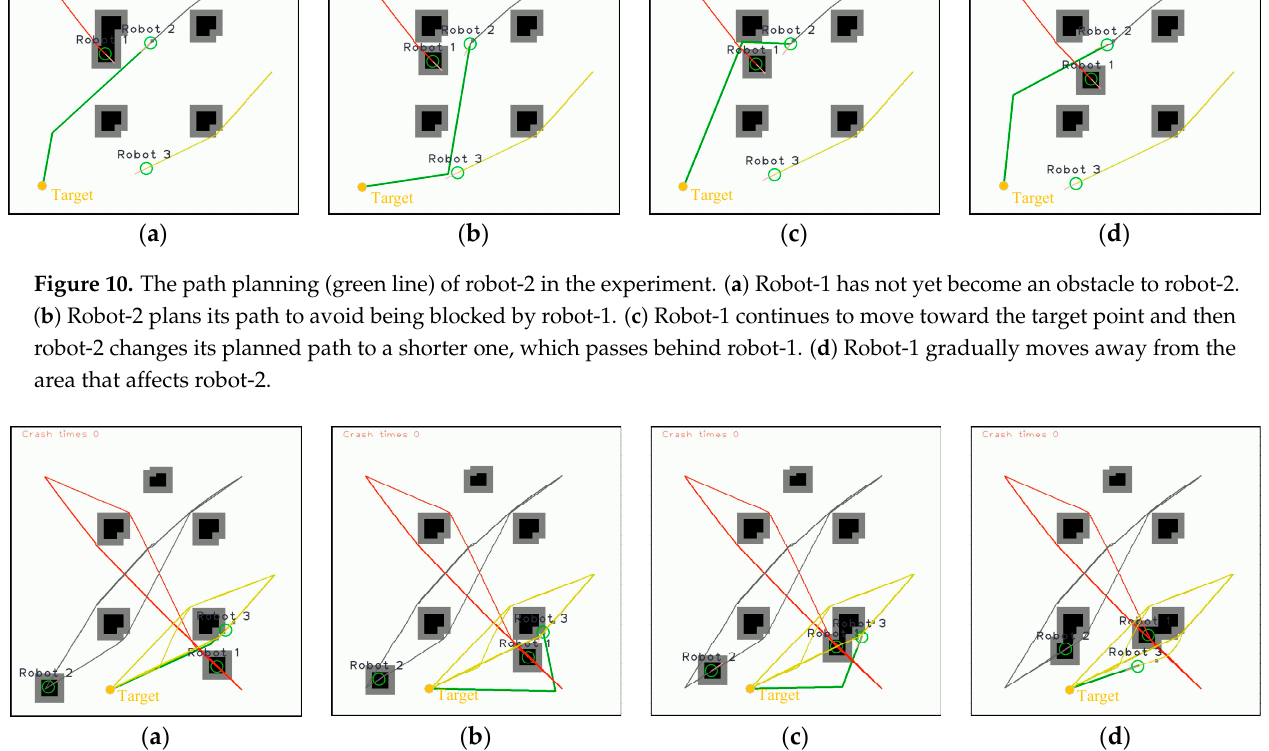
Figure 11. The path planning (green line) of robot-3 in the experiment. ( a ) Robot-1 has not yet become an obstacle to robot-3. ( b ) Robot-3 plans its path to avoid being blocked by robot-1 on its return trip. ( c ) Robot-1 continues to move back to its starting point, and then robot-3 changes its planned path to a shorter one that is behind robot-1. ( d ) Robot-1 gradually moves away from the area that affects robot-3. Robot-3’s path becomes similar to the planned path in (a).